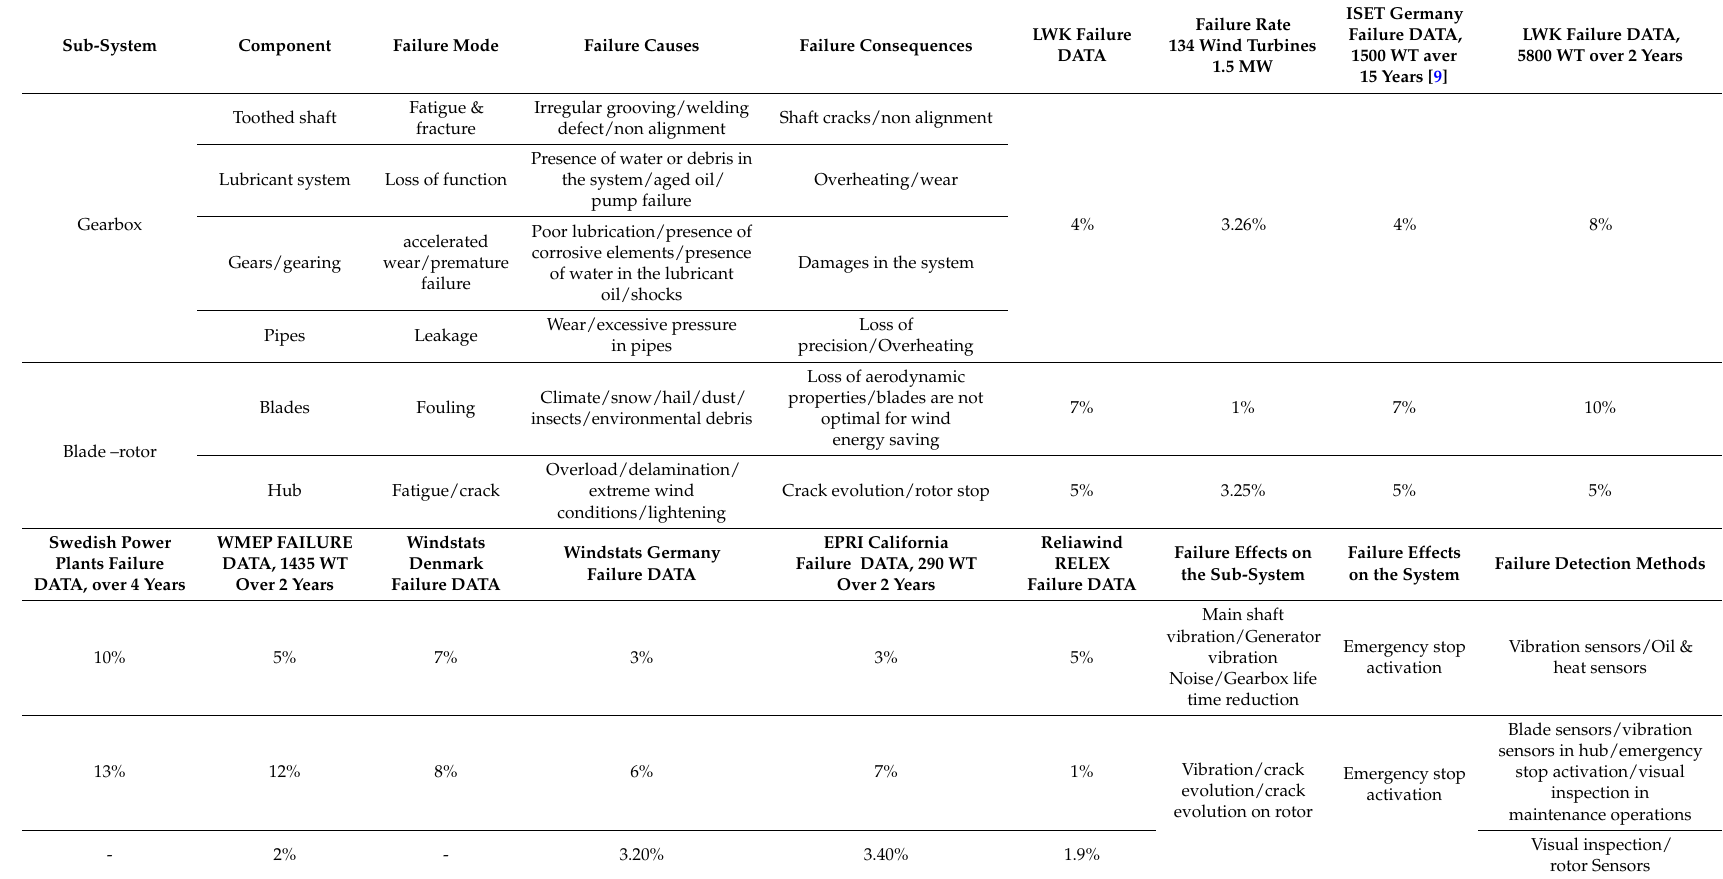
Table A1. Sample of a 2 MW FMEA